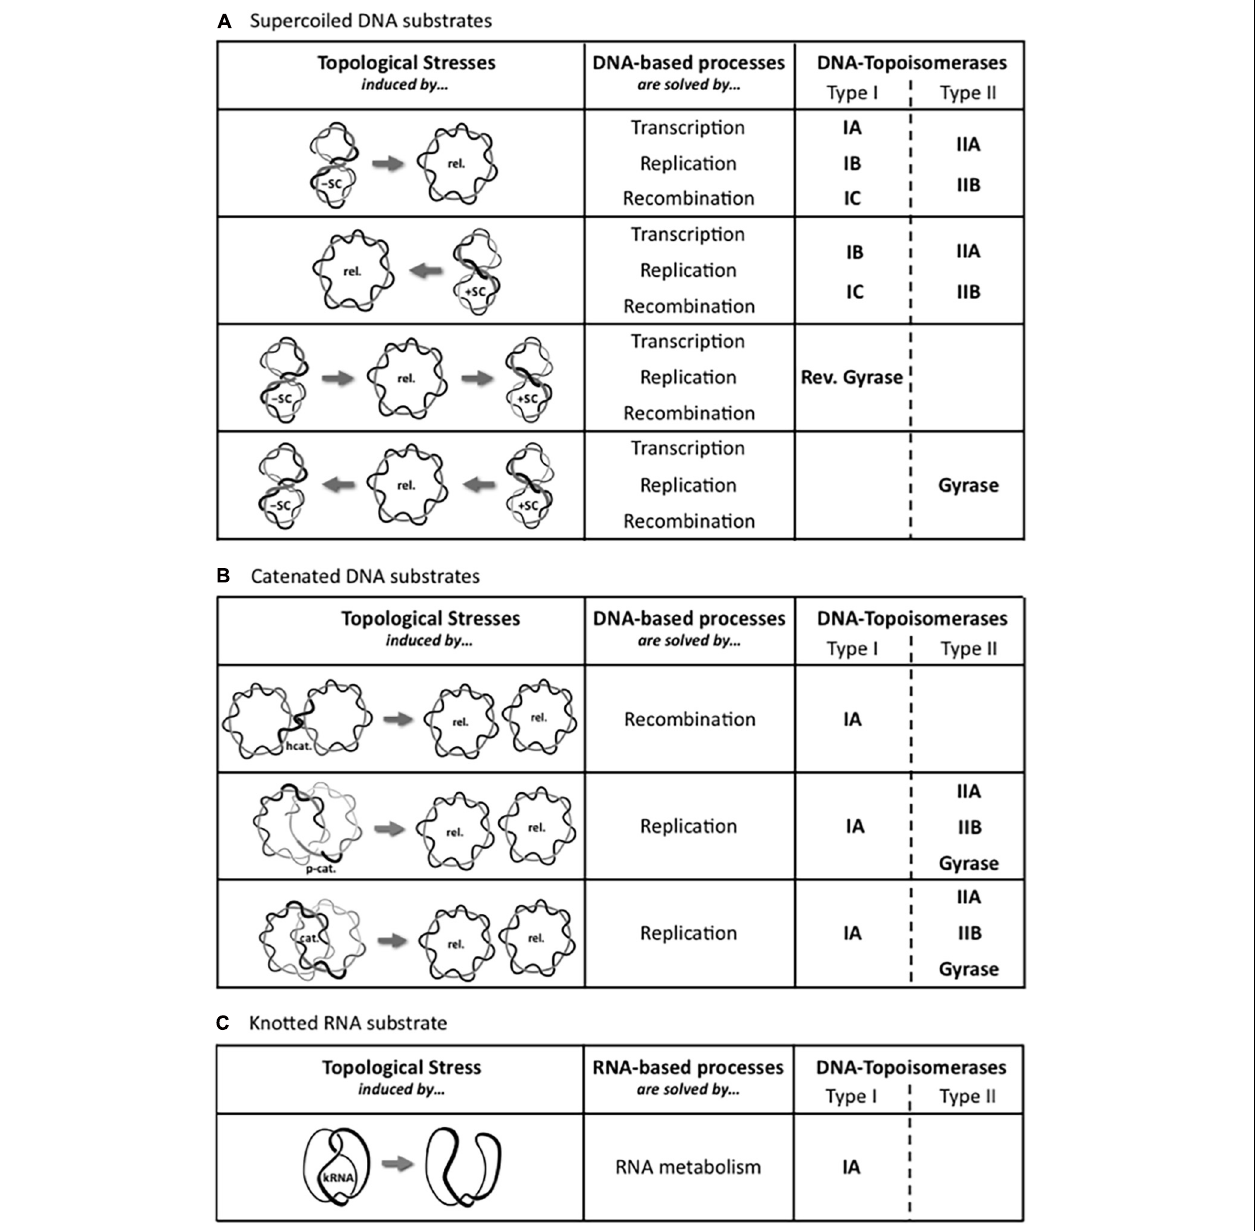
FIGURE 2 | Set of DNA-topoisomerases involved depending on the topological stress. The movement of DNA-based processes, such as transcription, DNA replication, and recombination, locally induces different topological stresses, which are schematically represented. These local torsional stresses have been observed within (A) Supercoiled DNA substrates formed within a single molecule of double-stranded DNA, between (B) Catenated DNA substrates involving two molecules of double-stranded DNA, or within (C) Knotted RNA substrate formed within a single molecule of single-stranded RNA, and are solved by either type I or type II DNA-topoisomerases, or by both types. The two types are subdivided into their respective subfamilies: IA, IB, and IC; IIA and IIB. The gray arrow represents the DNA-topoisomerase activity. Abbreviations designing topological forms are: relaxed DNA (Rel.), negatively supercoiled DNA (-SC), positively supercoiled DNA (+SC), pre-catenane (p-cat.), catenane (cat.), hemicatenane (hcat.), and knotted RNA